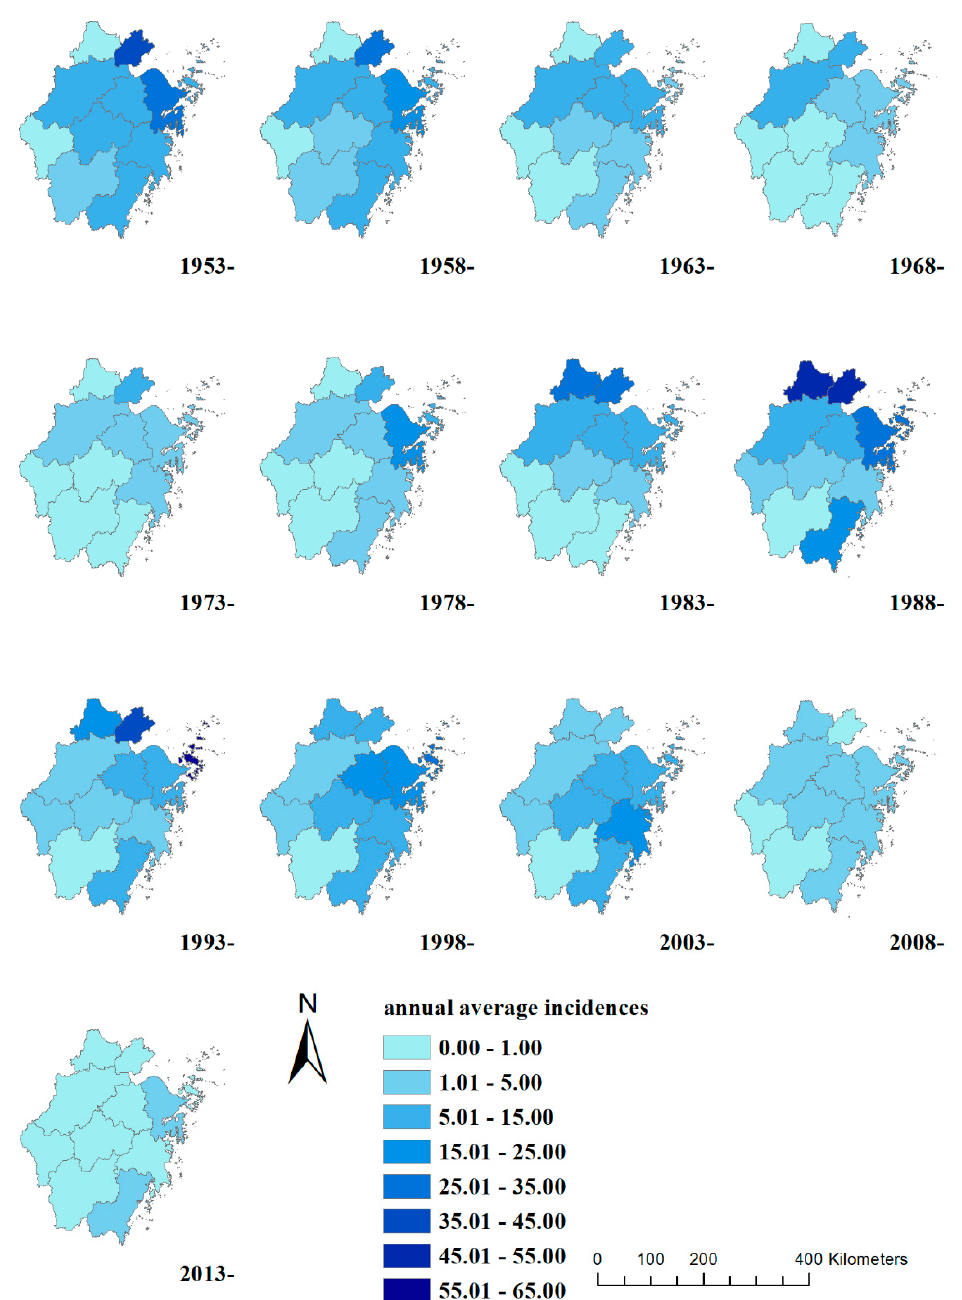
Figure 3. Annual average incidences of typhoid and paratyphoid in Zhejiang Province from 1953 to 2014. (Huzhou being detached from Jiaxing in 1983, and the incidences in Huzhou being 0.00 per 100,000 population before 1983; Quzhou being detached from Jinhua in 1985, and the incidences in Huzhou being 0.00 per 100,000 population before 1985).